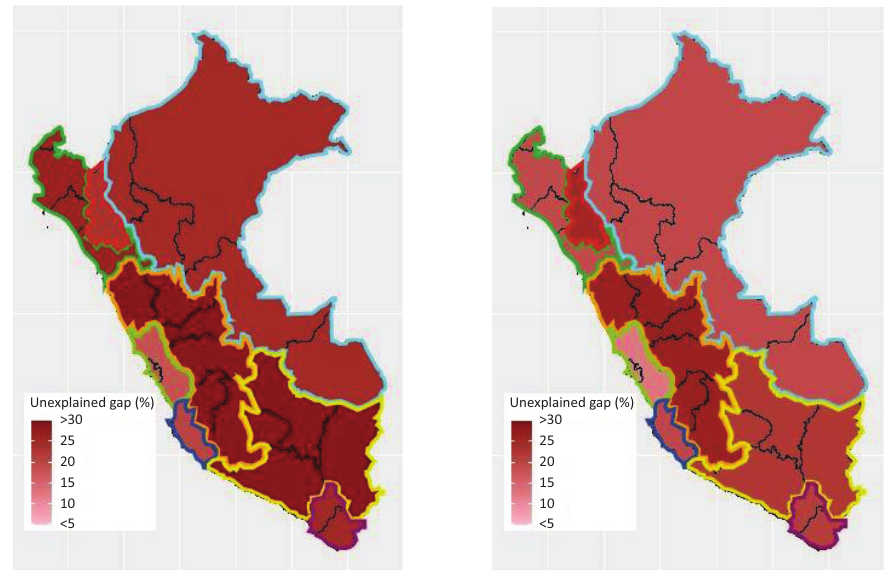
Figure 4. Average raw and unexplained wage gaps across macro regions. Notes: Raw gender gaps are computed using the ln (hourly wage) separately for each macro region; data included has been weighted using sampling weights from the ENAHO survey; unexplained gaps are computed using the base O‐B